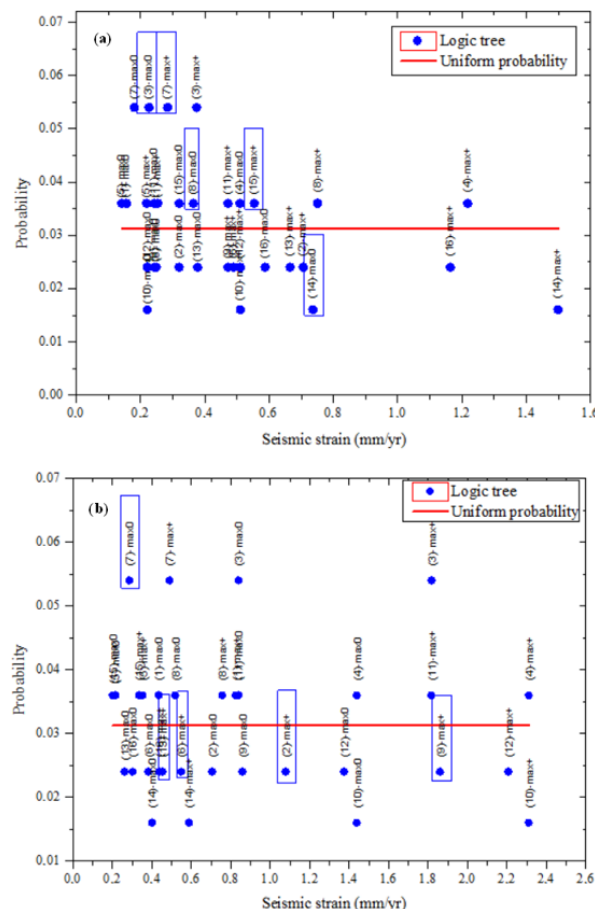
Figure 7. Seismic strain and probability for each of the 32 models that result from the logic tree proposal of Vilanova and Fonseca (2007). The scenarios outlined are the ones chosen to be tested with neotectonics modelling. (a) The LTV source zone. (b) The 1755 source